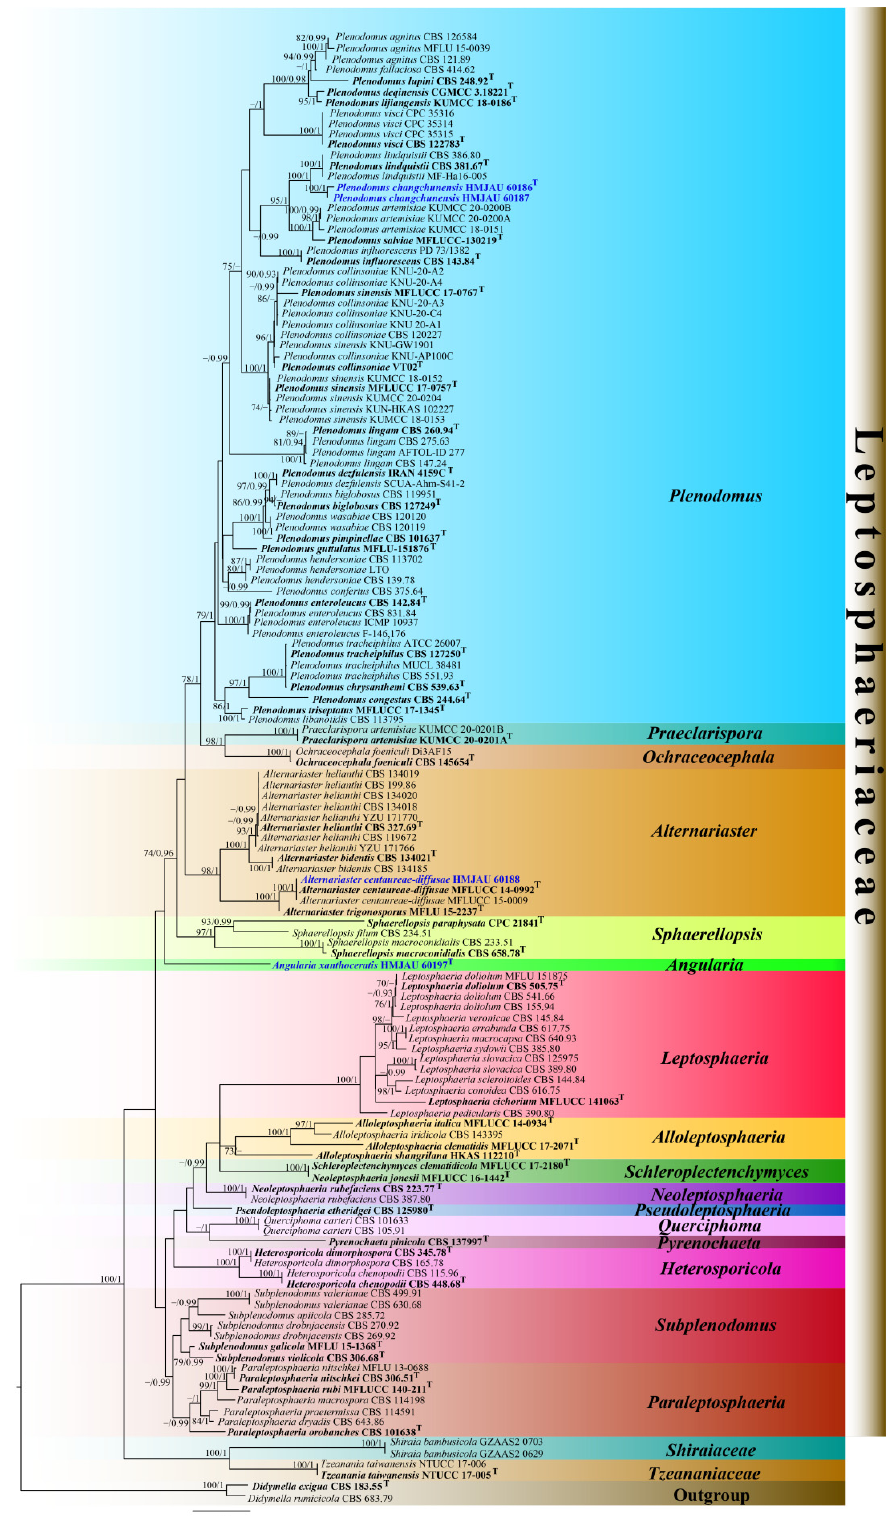
Figure 2. The best scoring RAxML tree of Leptosphaeriaceae based on a concatenated ITS, LSU, SSU, and tub 2 datasets. The tree is rooted with Didymella exigua (CBS 183.55) and D. rumicicola (CBS 683.79). RAxML bootstrap support values ≥ 70% (ML, left) and Bayesian posterior probabilities ≥ 0.90 (BPP, right) are shown near the nodes. The new isolates are in blue. The type strains are in bold and marked with T .